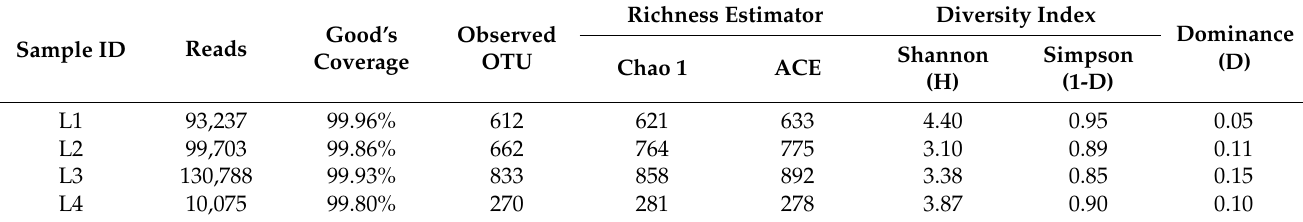
Table 1. Richness and diversity statistical data generated from the metabarcoding